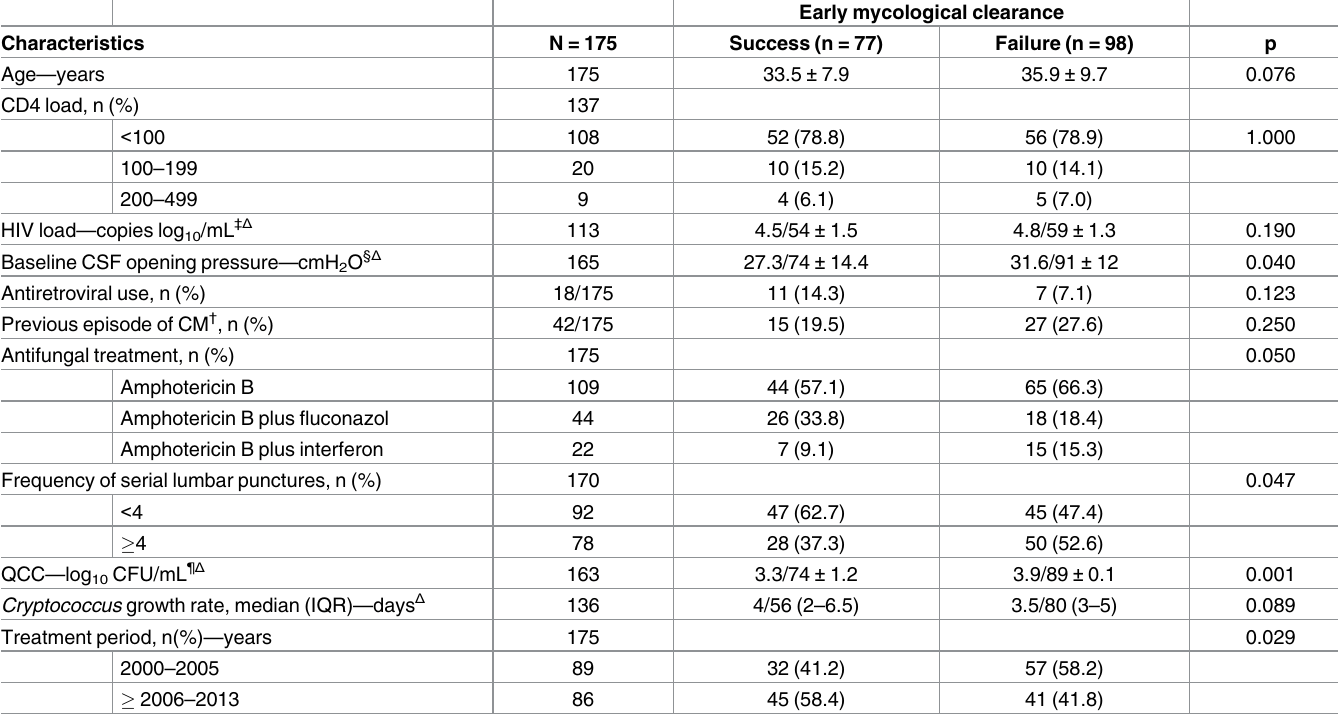
Table 2. Comparison of baseline characteristics according to the status of early mycological clearance(successvs failure) among cases with HIV-associated CM in Peru *